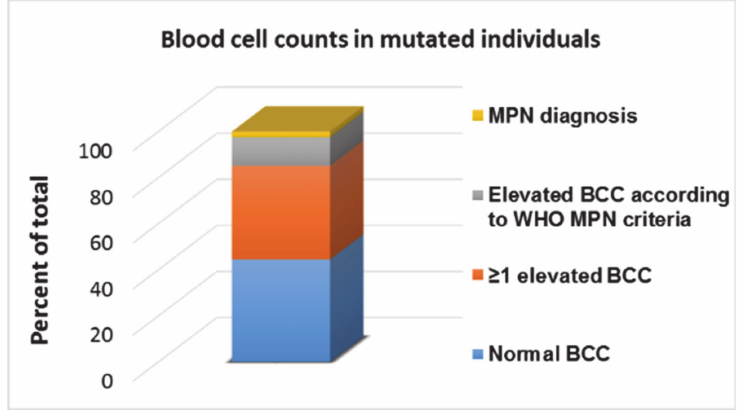
Figure 3. Elevated blood cell counts (BCC) in JAK2V617F and CALR mutation positives in the general population. Deep molecular screening on 19,958 individuals of the 21,205 total from the Danish General Suburban Population Study (GESUS) cohort, revealing 645 to be positive for JAK2V617F (N = 613) or CALR type 1 and type 2 (N = 32). Normal BCC was found in 44% (N = 287), 41% (N = 262) had elevated BCC including hematocrit, erythrocytes, leukocytes, and platelets, whereas 12% (N = 80) had elevated BCC counts fulfilling WHO MPN criteria and 2.5% (N = 16) were already known patients with an MPN